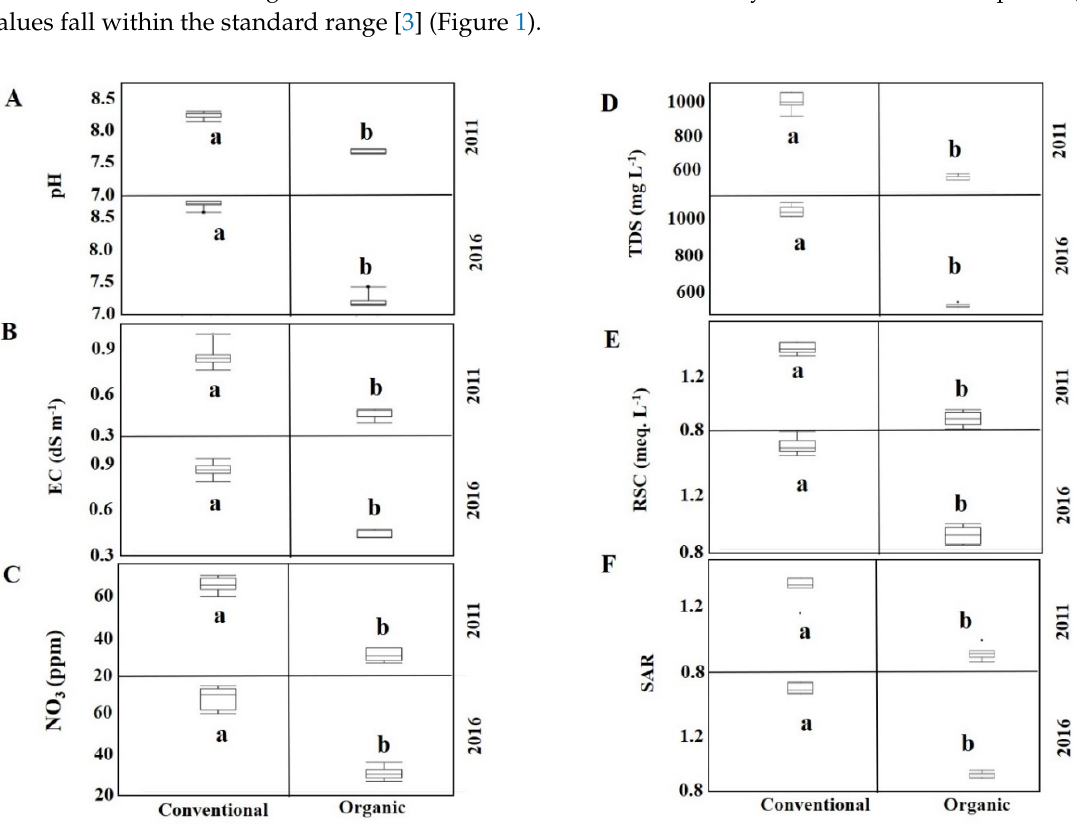
Figure 1. Comparison between the environmental impacts of organic vs. conventional rice cultivation on groundwater quality parameters (( A ). pH, ( B ). electrical conductivity (EC), ( C ). NO 3 , ( D ). total dissolved solids (TDS), ( E ). residual sodium carbonate (RSC), and ( F ). sodium absorption ratio (SAR)) (n = 21 for each year) in Kaithal, Haryana, India. Different letters indicate significant difference at a 5% level of significance.